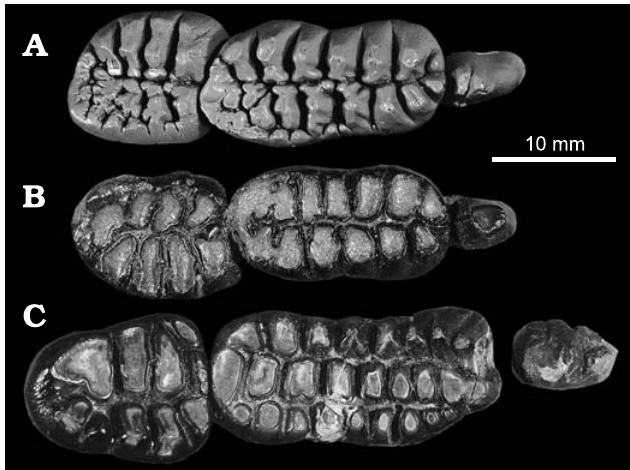
Fig. 15. Teeth of multituberculate mammal from the lower Paleocene Puercan in the San Juan Basin, New Mexico . A . Taeniolabis sp., AMNH 117415, cast, occlusal view of right p4–m2. B , C . Taeniolabis taoensis Cope, 1882. B . AMNH 16310, occlusal view of the left p4–m2. C . AMNH 16321, occlusal view of the right